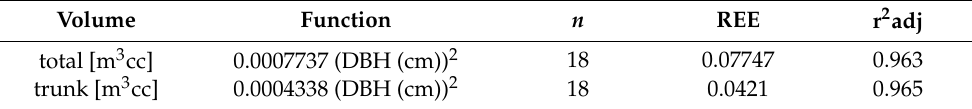
Table 2. Functions of total volume and individual trunk volume.